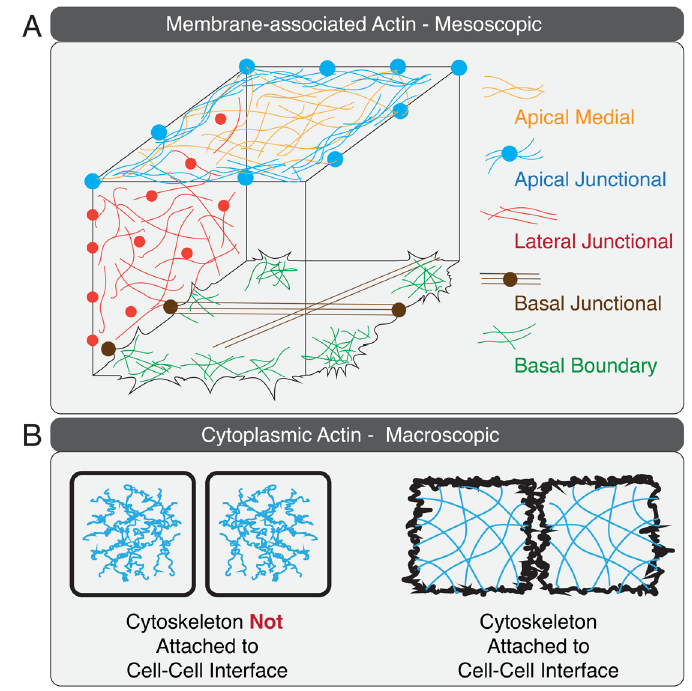
Figure 1. Actin organization in a three-dimensional epithelial cell. ( A ) Actin arrangement on the apical, lateral, and basal membranes of the epithelial cell is illustrated at the mesoscopic cellular level. ( B ) Connectivity between cell–cell interface and the actin cytoskeleton is illustrated at the macroscopic multi-cellular